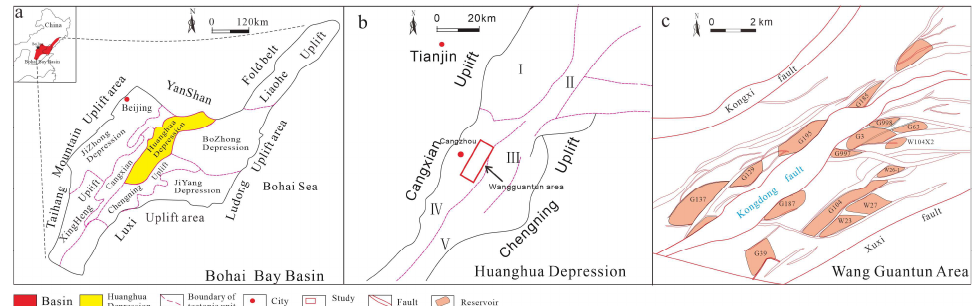
Figure 1. The geographical and structural maps of the Wang Guantun Area. ( a ) Bohai Bay Basin; ( b ) Huanghua Depression; ( c ) Wang Guantun area.